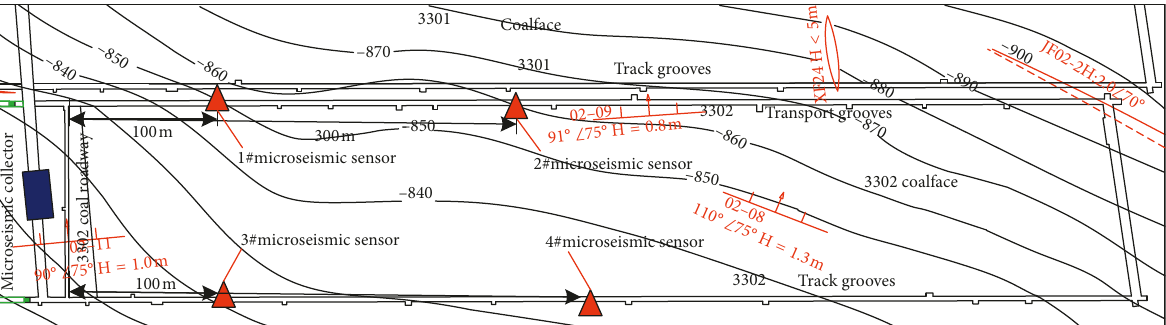
Figure 9: Layout diagram of microseismic collector and microseismic